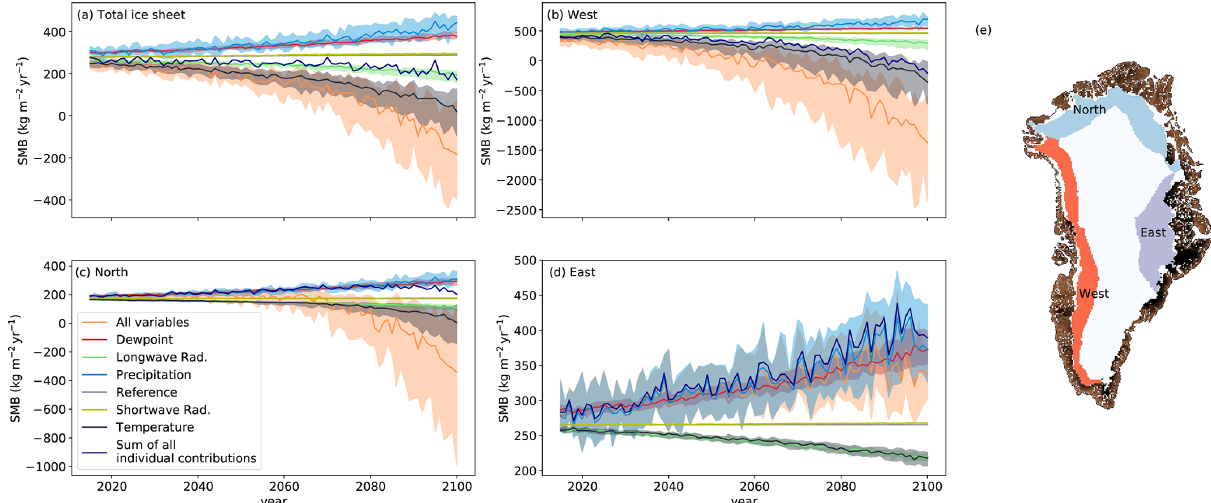
Figure 7. SMB for single-forcing simulations for the entire GrIS (a) and selected regions (b–d) . The variable named in the legend is transient for scenario SSP585, while all other variables are the ERA-Interim mean. “All variables” indicates that all variables are transient (the same as Fig. 2). “Reference” shows the historical climatology for all variables with precipitation distribution as in CMIP. (e) Positions of the selected regions. Regions “north” and “west” are at elevations of 1000–2000m. The southeast is precipitation driven and the change in SMB with altitude is less developed; therefore, the region “east” is at elevations of